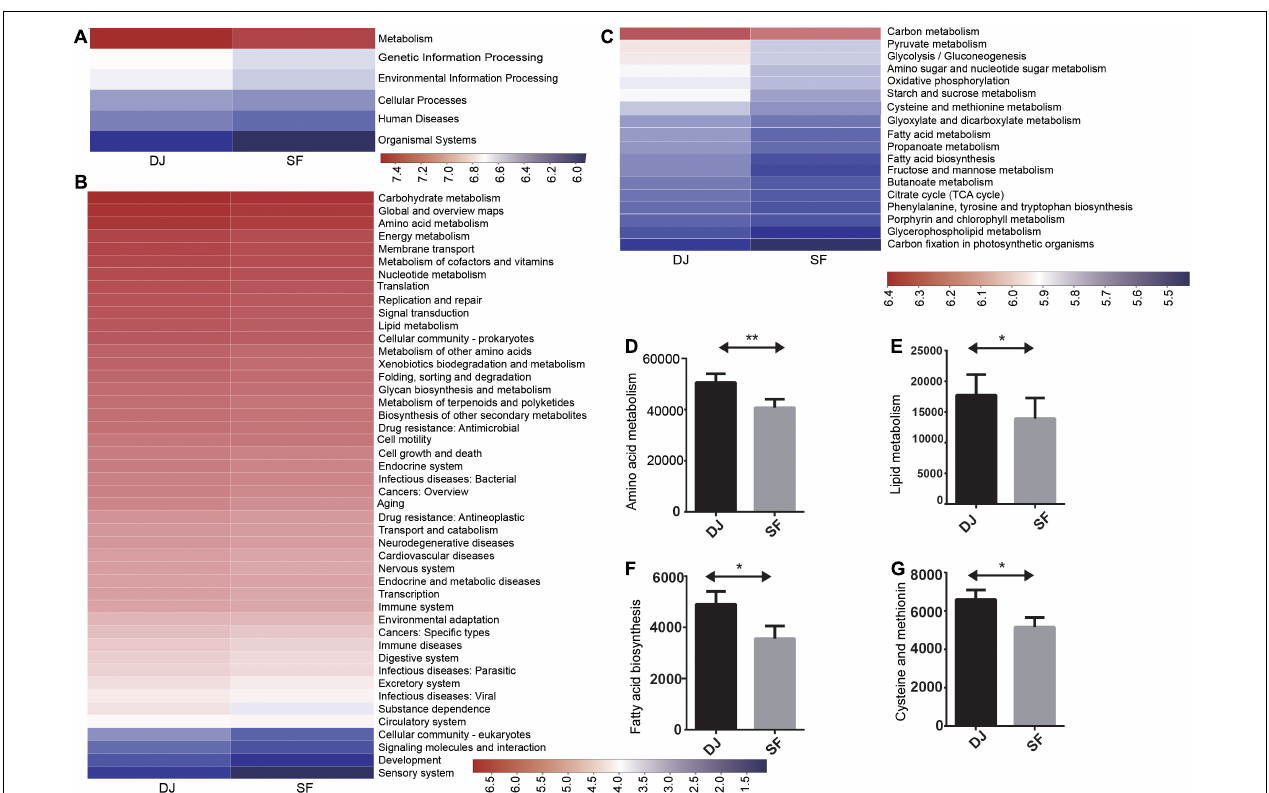
FIGURE 8 | Predictive functions of the bacterial communities in Dajiang and Sufu products. (A) Overall Kyoto Encyclopedia of Genes and Genomes (KEGG) gene function statistics (Level 1). (B) Heatmap of functional pathways (Level 2). (C) Heatmap of functional pathways (Level 3). (D) Amino acid metabolism. (E) Lipid metabolism. (F) Fatty acid biosynthesis. (G) Cysteine and methionine metabolism. * P < 0.05, ** P <